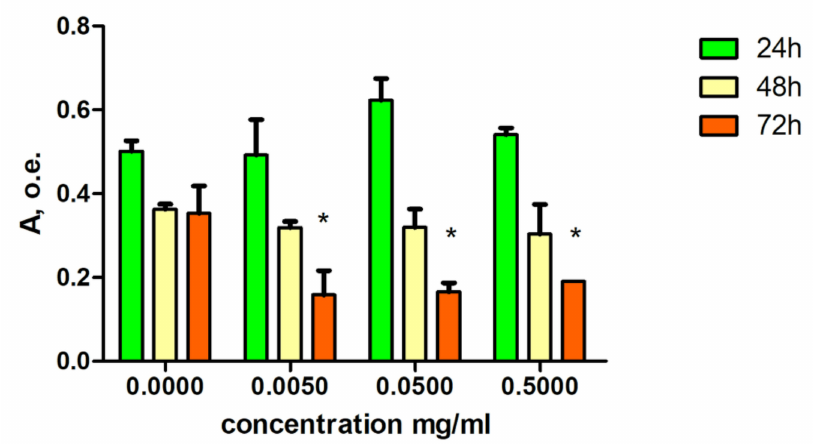
Figure 4. The e ff ect of a suspension of chitosan nanoparticles on the viability of cultured cardiomyocytes. Cell viability was measured by MTT assay. Absorbance (A) positively correlates with number of alive cells. CNPs reduce cell viability in tested concentrations only after 72 h incubation. Mean ± SEM. * – p < 0.05 with respect to